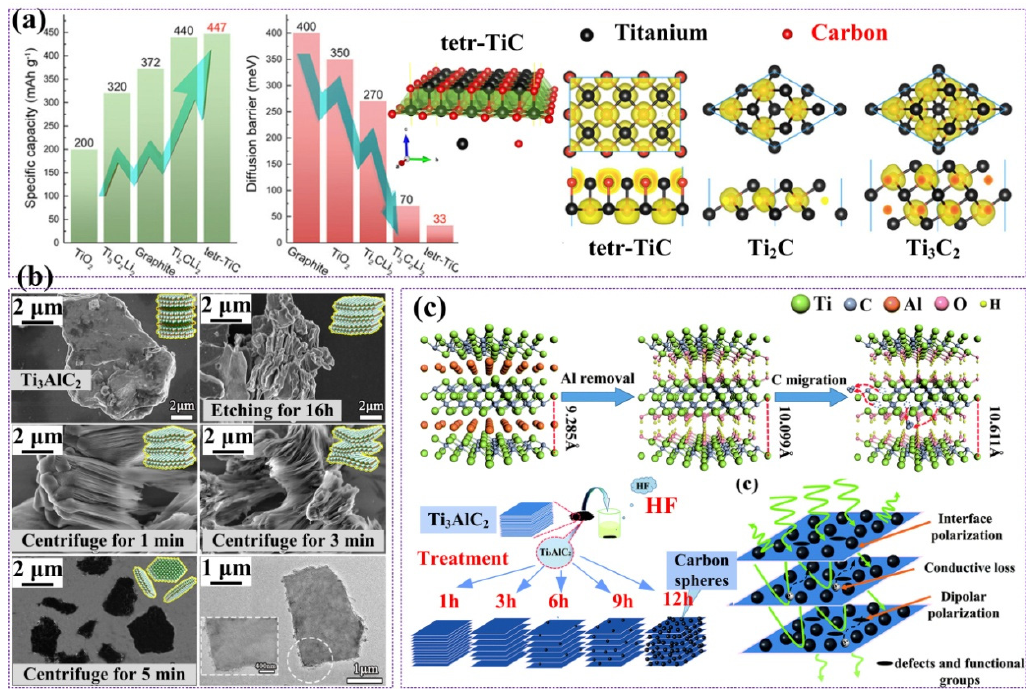
Figure 8. ( a ) The optimized geometries of the free-standing tetr-TiC sheet and the comparison of different titanium carbide materials, with permission from Reference [5], copyright (2018) American Chemical Society. ( b ) The morphological evolution of Ti 3 C 2 T x (T = -O,-OH or -F) after LiF/HCl etching of Ti 3 AlC 2 and centrifuging for different times, with permission from Reference [24], copyright (2019) American Chemical Society. ( c ) The synthesis mechanism of Ti 3 C 2 T x MXenes/nanocarbon-sphere hybrids. First, the Al layer is removed from the corresponding MAX phase by HF. Second, part of the carbon atoms are migrated to the surface of the Ti 3 C 2 T x MXenes. This process can be controlled by using different HF treatment times, and microwave absorption effects are also exhibited. Used with permission from Reference [3], copyright (2018) The Royal Society of Chemistry.